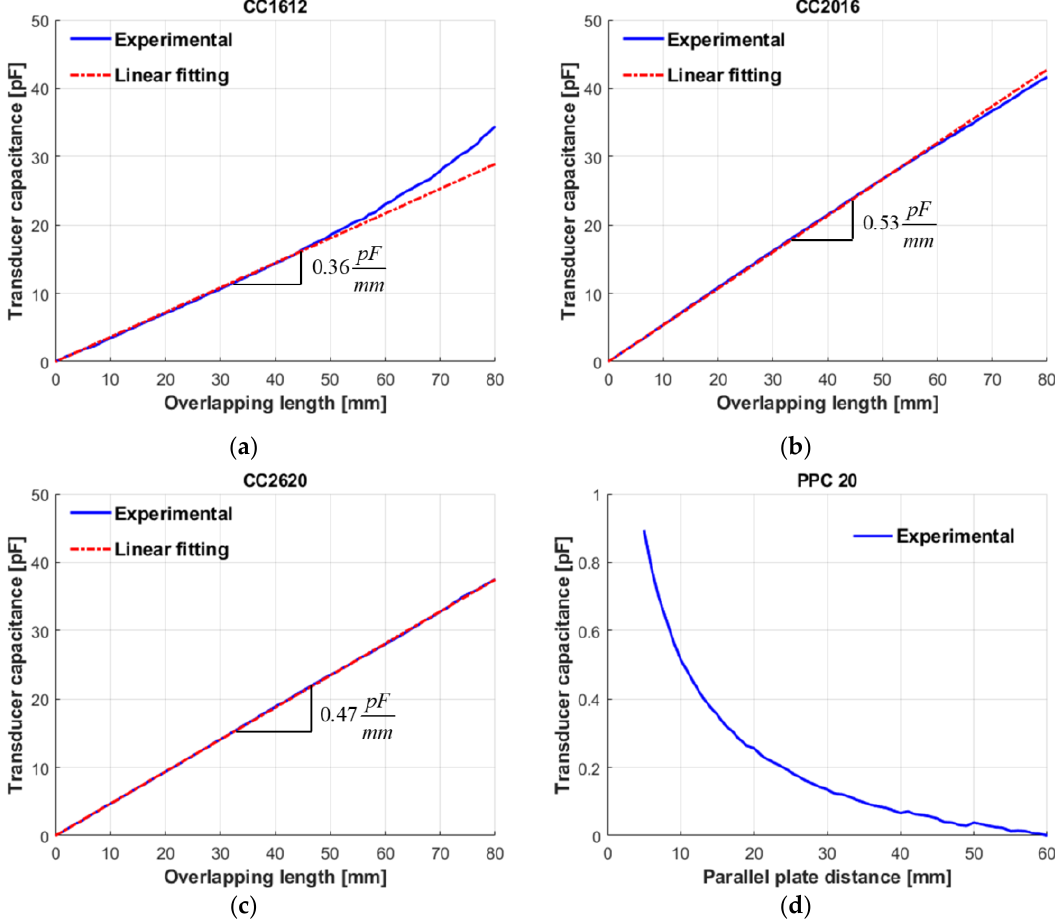
Figure 5. Experimental characteristic curves of the developed capacitive transducers: Panel ( a ) CC1612 transducer; Panel ( b ) CC2016 transducer; Panel ( c ) CC2620 transducer; Panel ( d ) PPC20 transducer.